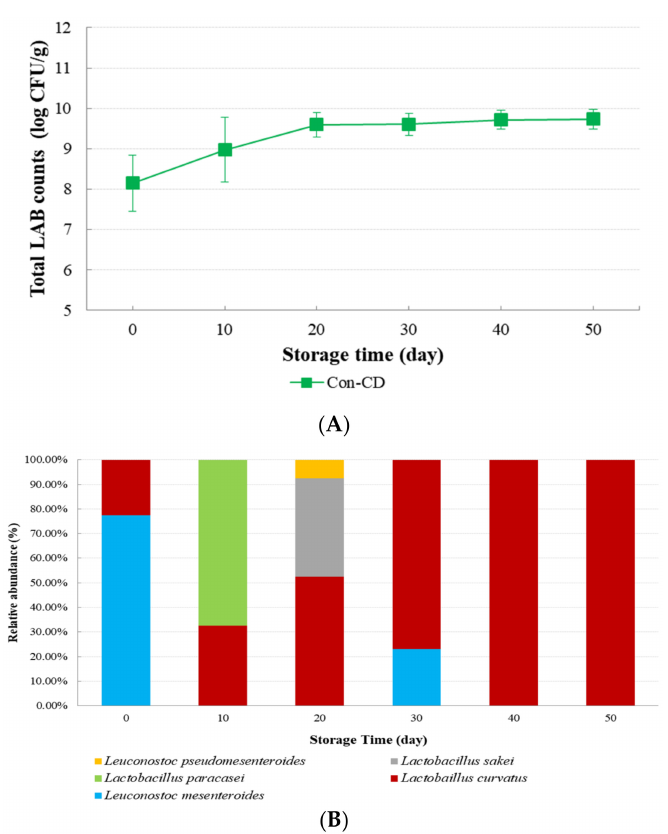
Figure 6. Total lactic acid bacteria cell counts and microbial community of Con-CD samples during 50 day at 10 ◦ C: ( A ) Total LAB counts; ( B ) microbial community.